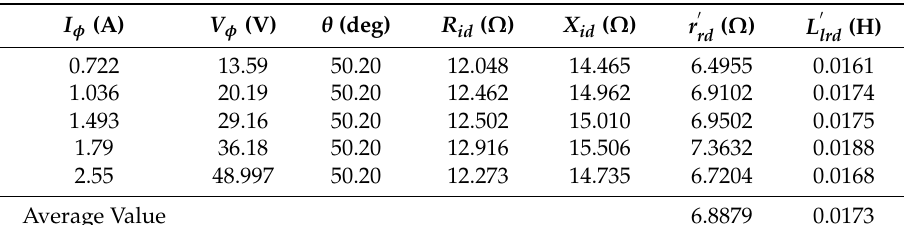
Table 4. The locked rotor test result (rotor d-axis aligned with phase-a).